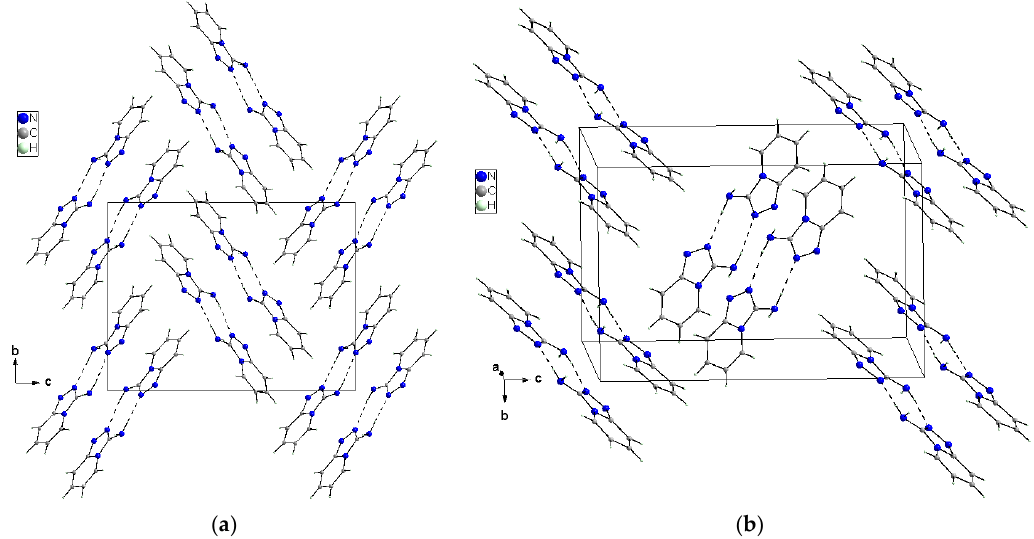
Figure 3. Crystal packing of the TPa-NH 2 molecules in the unit cell showing the N–H · · · N hydrogen-bonded dimers with an R 22 (8) graph viewed almost along [100] ( a ) and [210] directions ( b ). The optimized structure of the TPa-NH 2 molecule obtained from the DFT calcula- tions is shown in Figure 4, in which the numbering of the atoms is also defined. The calculated geometrical parameters are introduced in Table 1 for comparison with those obtained from the XRD studies. These values were used to calculate the vibrational and electron energy levels. It should be noted that the theoretical and experimental bond lengths, the angles between them as well as the torsional angles show a very good ac- cordance which proves that the theoretical model of the DFT calculations was chosen correctly. Figure 4. Molecular structure of TPa-NH 2 with numbering atoms. The Mulliken atomic charges determined in the present work for the studied com- pound are presented in Table S2. These results show that coupling between the pyridine and triazole rings as well as the substitution of the amino group at C(1) atom leads to a redistribution of electron density. The charges of the nitrogen atoms clearly vary de- pending on their place and function in the TP system. The N(1) and N(2) atoms in the triazole ring exhibit charge values of −0 .279 and −0 .281, respectively. The third nitrogen N(3) atom exhibits a higher charge value equal to −0 .243 because it is common for the both rings. The charge value of the fourth N(4) atom is significantly smaller ( −0 .406) be-